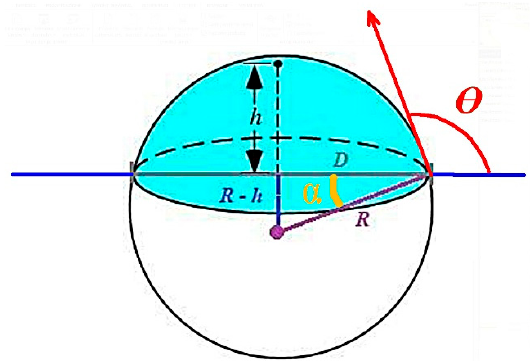
Figure 4. Droplet shape should be approximately regarded as a spherical cap of height h and diameter D, related to a sphere of radius R.